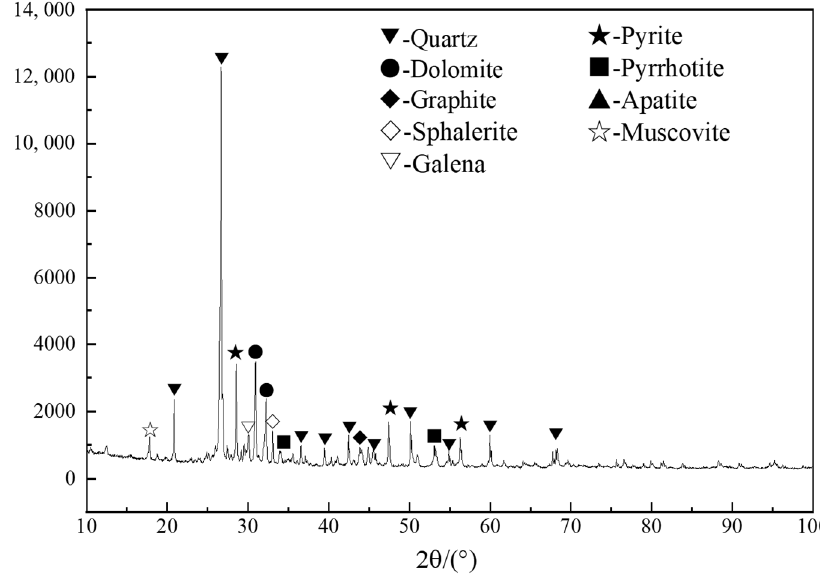
Figure 2. XRD pattern of the ore.